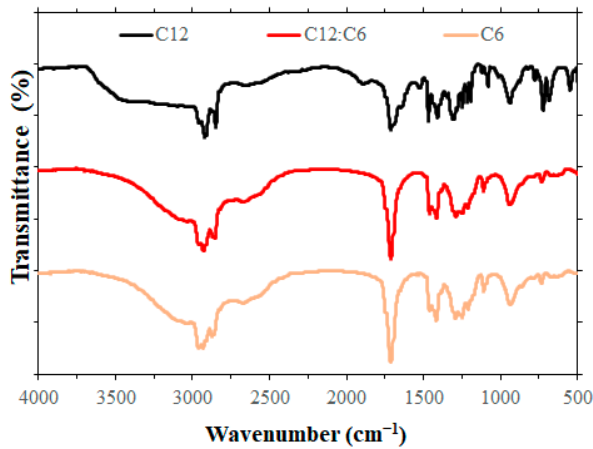
Figure 2. FTIR spectra of the fatty-acid mixture prepared and its individual components: C12 (black line), C12:C6 (red line), and C6 (orange line).